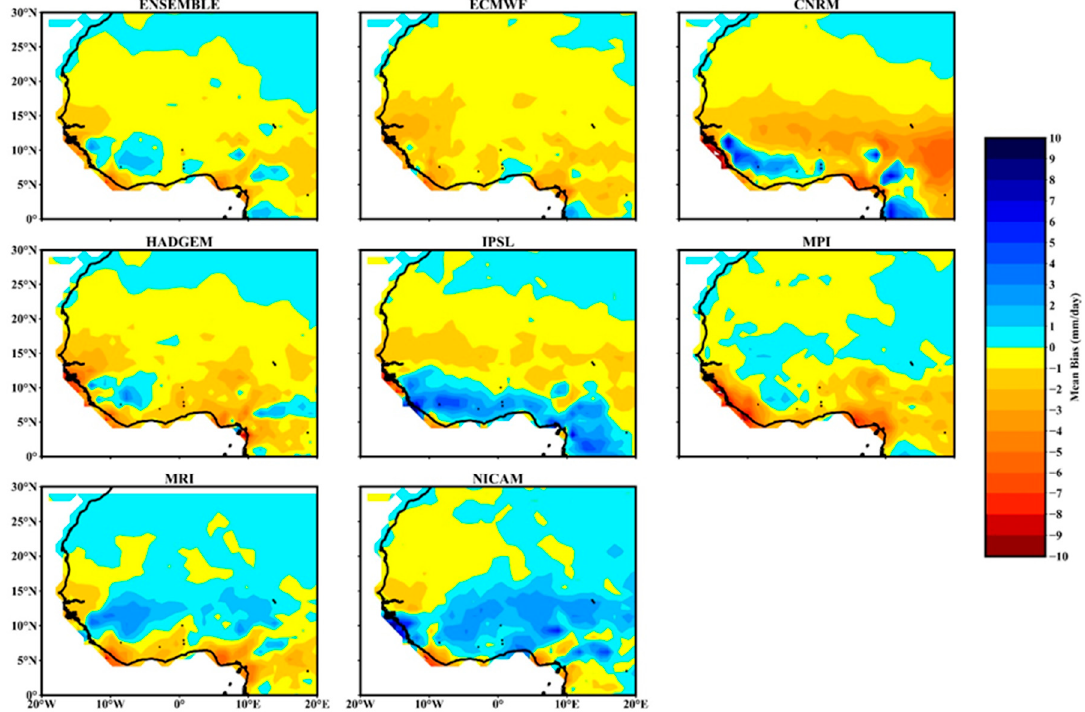
Figure 4. Mean bias of the daily climatology of precipitation (mm/day) relative to GPCC data.